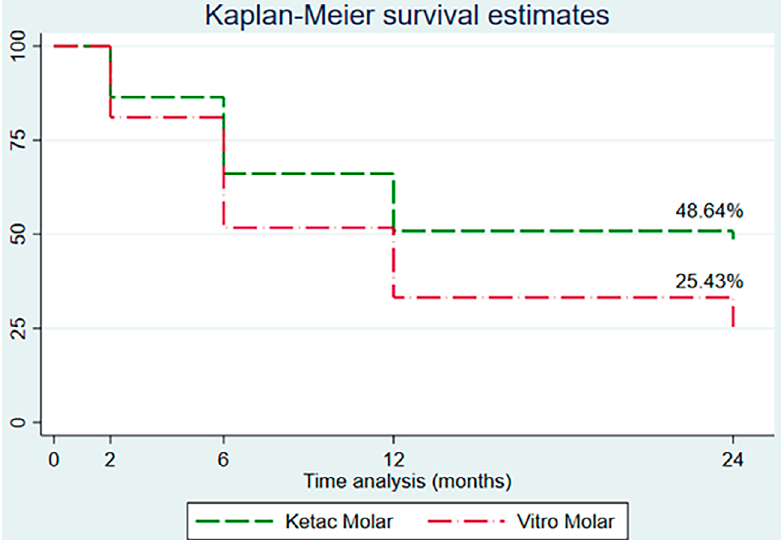
Figure 2- Kaplan-Meier survival